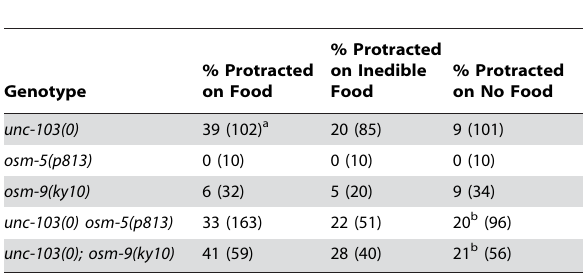
Table 1. Chemosensory mutations block food-deprivation suppression of sex-muscle